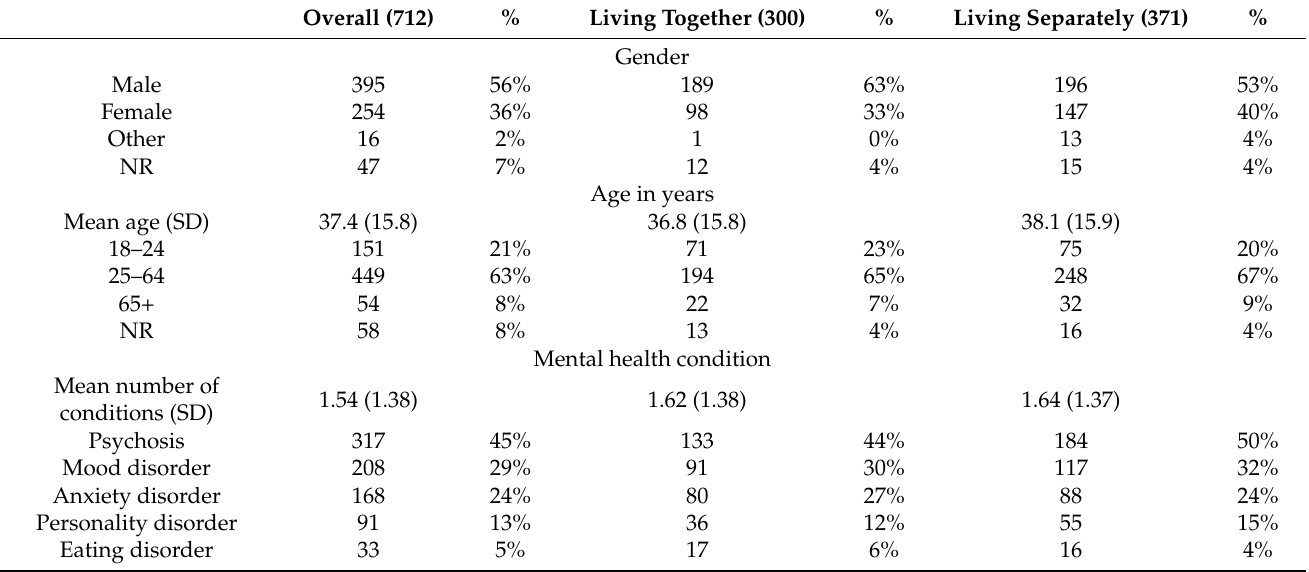
Table 2. Care recipient